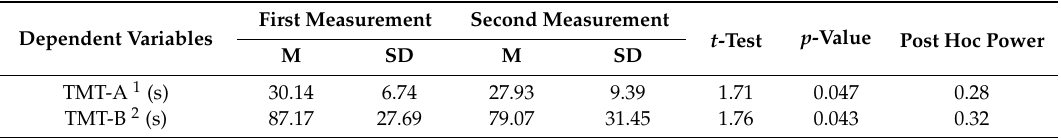
Table 2. The results of cognitive processing speed (Trail Making Test (TMT)-A) and executive functions (TMT-B) before and after 12 weeks of the Nordic Walking training program.